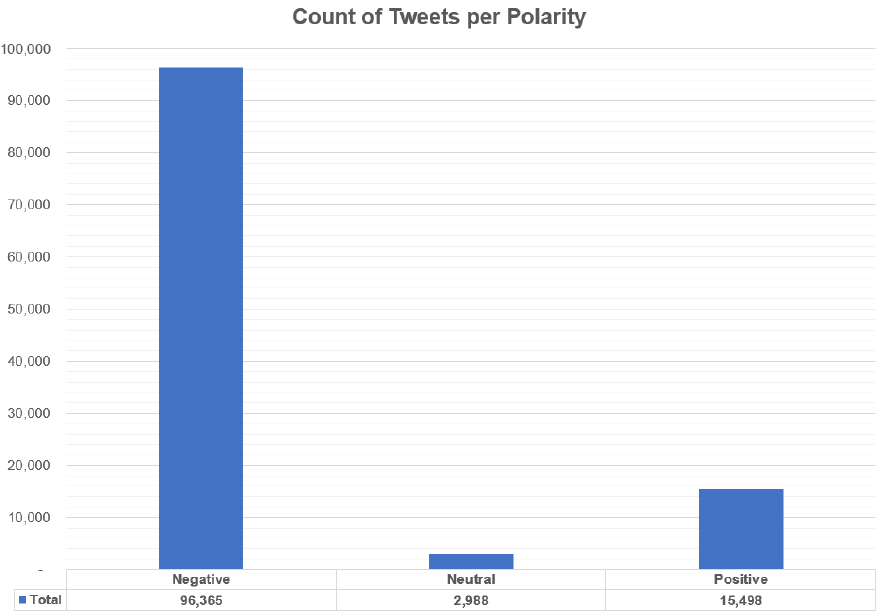
Figure 3. Count of the tweets according to polarity whether negative, neutral, or positive. The annotated data were then divided into training and testing data with a 70–30 split with the 30% testing data having an unlabeled dataset. After training, an accuracy rate of 84.83% was attained by the Multinomial Naïve Bayes model. Seen in Table 8 below is the Confusion Matrix and other metrics. Table 8. The Confusion Matrix and other metrics from the training dataset using the model. Label